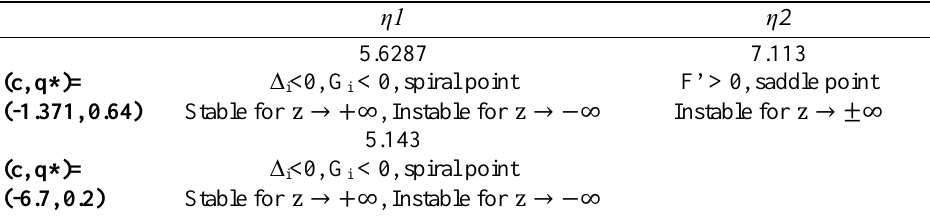
Table 1. Types of equilibrium points and their stability.